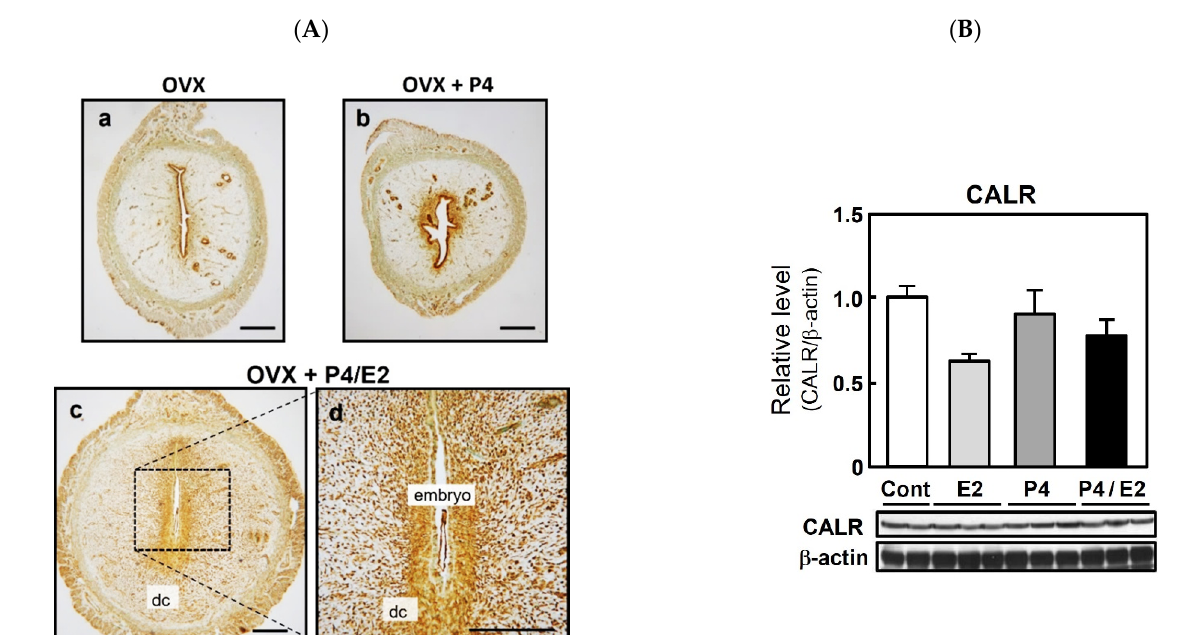
Figure 2. Expression of calreticulin (CALR) in the delayed implantation model and effects of ovarian steroids on uterine CALR expression in rats. Pregnant rats were ovariectomized (OVX) on day 4 of pregnancy and injected with or without progesterone (P4, 3 mg/day) on days 4 to 9 to delay implantation ( Aa , Ab ). n = 3. To initiate implantation in some P4-primed rats, estradiol-17 β (E2, 500 ng) was injected on day 8 of pregnancy ( Ac , Ad ). n = 3. Uterine sections were prepared 48 h after E2 injection and CALR was detected by immunostaining; dc, decidual cells. Scale bars = 250 μ m. Ovariectomized rats were given injections of P4 (3 mg) daily for 3 days and/or a single injection of E2 (500 ng) on the third day ( B ). Control (Cont) rats received neither steroid. Uteri were collected 24 h after E2 injection and/or the final P4 injection. CALR was detected in uterine lysates via immunoblotting and its expression level was normalized to that of β -actin. Data represent the mean ± SEM ( n = 3).